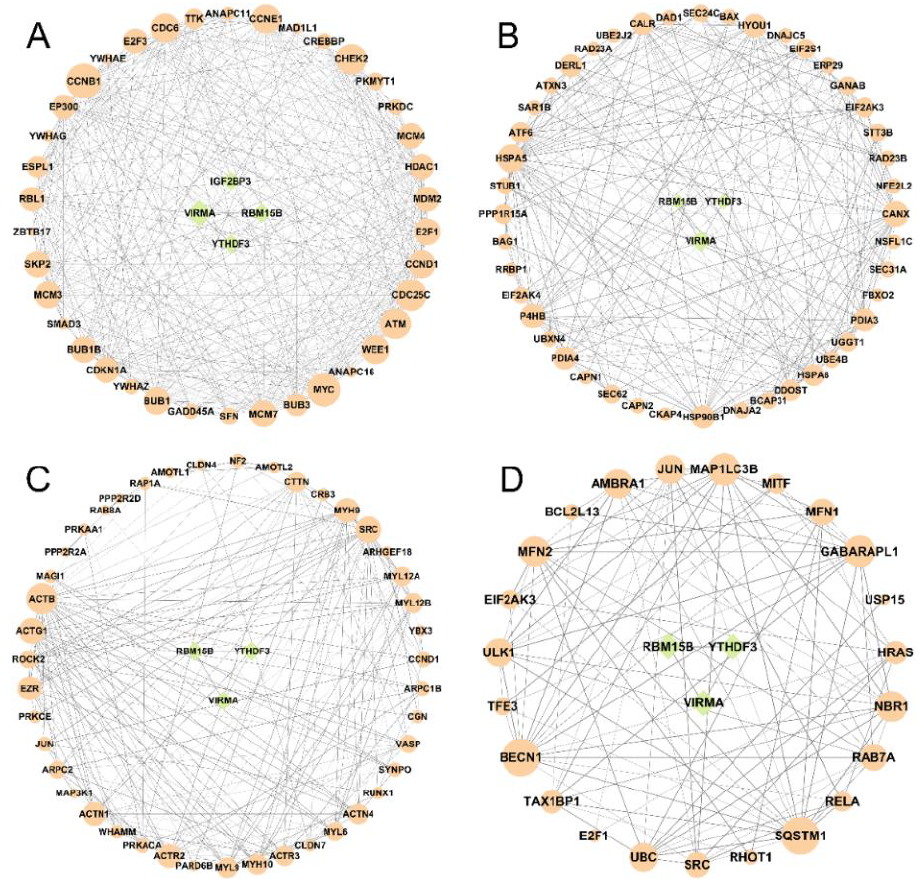
Figure 8. The interactions between m6A regulators (green circle) and the genes (orange circle) from the KEGG enrichment pathways of ( A ) cell cycle, ( B ) ER, ( C ) tight junction, and ( D ) mitophagy. To detect the substrates of m6A methylation regulators, the writers RBM15B, VIRMA, METTL5, and ZC3H13 and the readers YTHDC2, YTHDC1, YTHDF3, and IGF2BP3 were selected as well as the cell cycle genes CCNB1 , MYC , CDC25C , ATM , and CHEK2 (Figure 9A); the genes of protein processing in ER HSPA5 , CANX , P4HB , HSP90B1 , and PDIA3 (Figure 9B); the tight junction genes A CTB , SRC , ACTG1 , MYH9 , and ACTR2 (Figure 9C); and the mitophagy genes BECN1 , SQSTM1 , GABARAPL1 , MAP1LC3B , and MFN2 (Figure 9D). The m6A methylation levels of transcripts were observed by IGV and shown in Figure